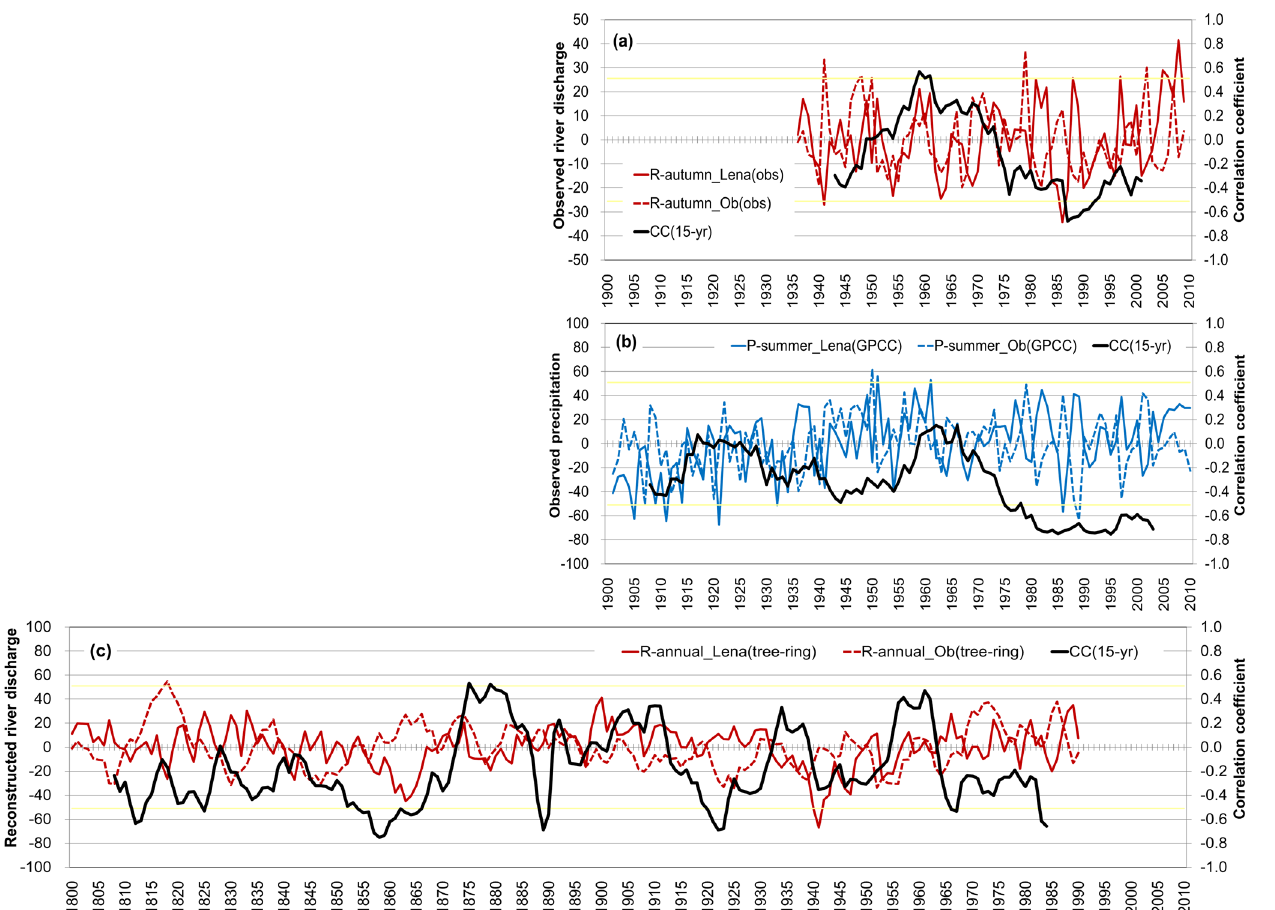
Figure 2. Time series of (a) observed autumn R during 1936–2009, (b) observed summer P during 1901–2010, and (c) tree-ring- reconstructed annual R during 1800–1990 of the Lena and Ob rivers. Red (blue) solid and dashed lines denote the R ( P ) values of the Lena and Ob, respectively. Thick black lines denote 15-year running correlations between the Lena and Ob R and P values. The confidence levels at 90, 95, and 98% for the 15-year correlation are 0.44, 0.51 (yellow lines), and 0.59. Note that the axes of the R and P are shown on the left side of the panel and the axes of the correlations are shown on the right side.